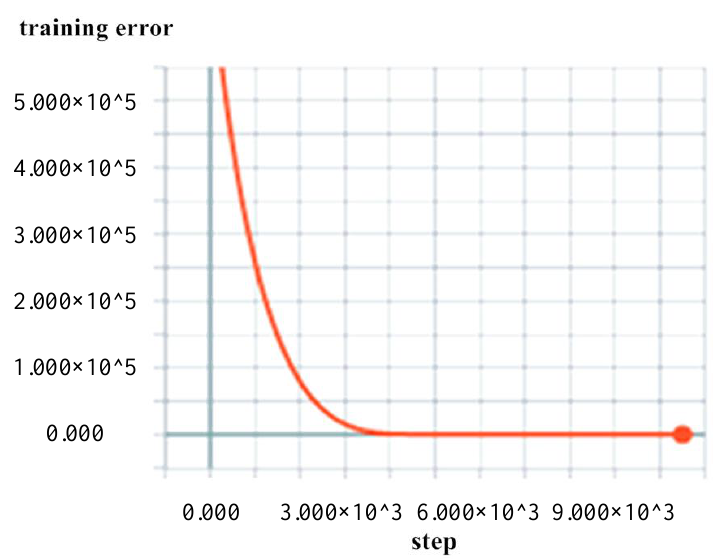
Figure 13. BI-LSTM-RNN training error change diagram.